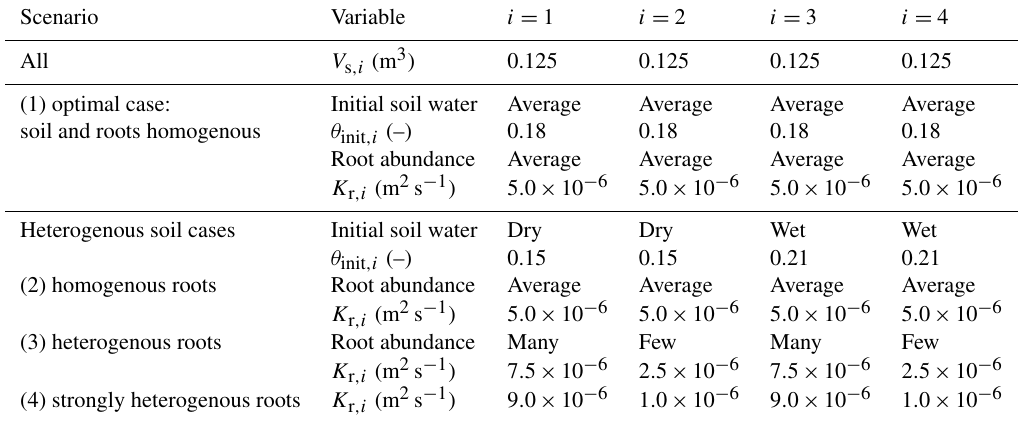
Table 1. Parameters and initial conditions applied for each of the scenarios in the conceptual model for the compartments ( i = 1...4). Given are the differences between scenarios in words and the corresponding manipulations in initial states and